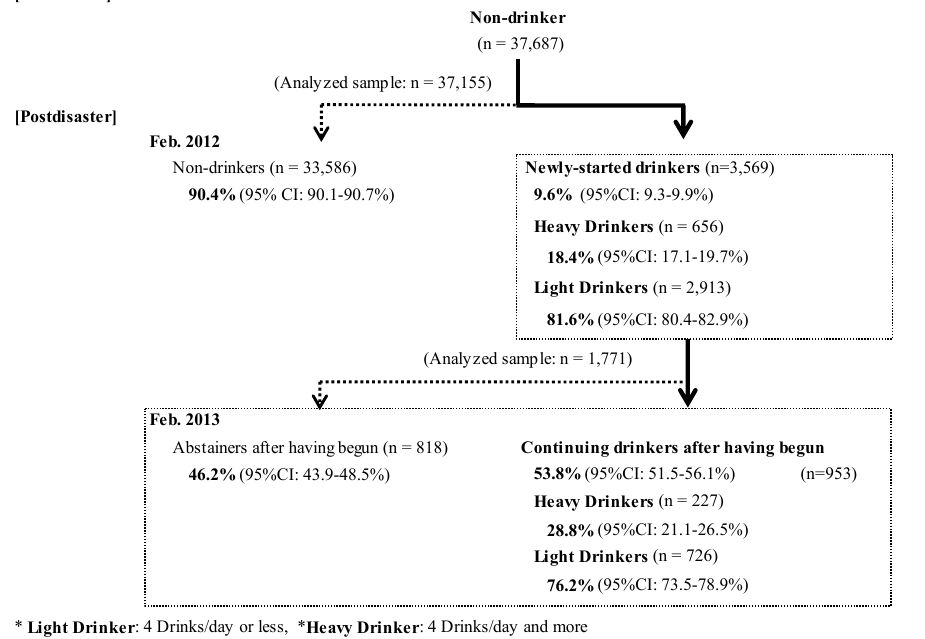
Figure 2. Prevalence of newly ‐ started drinkers and continuing drinkers after having begun.